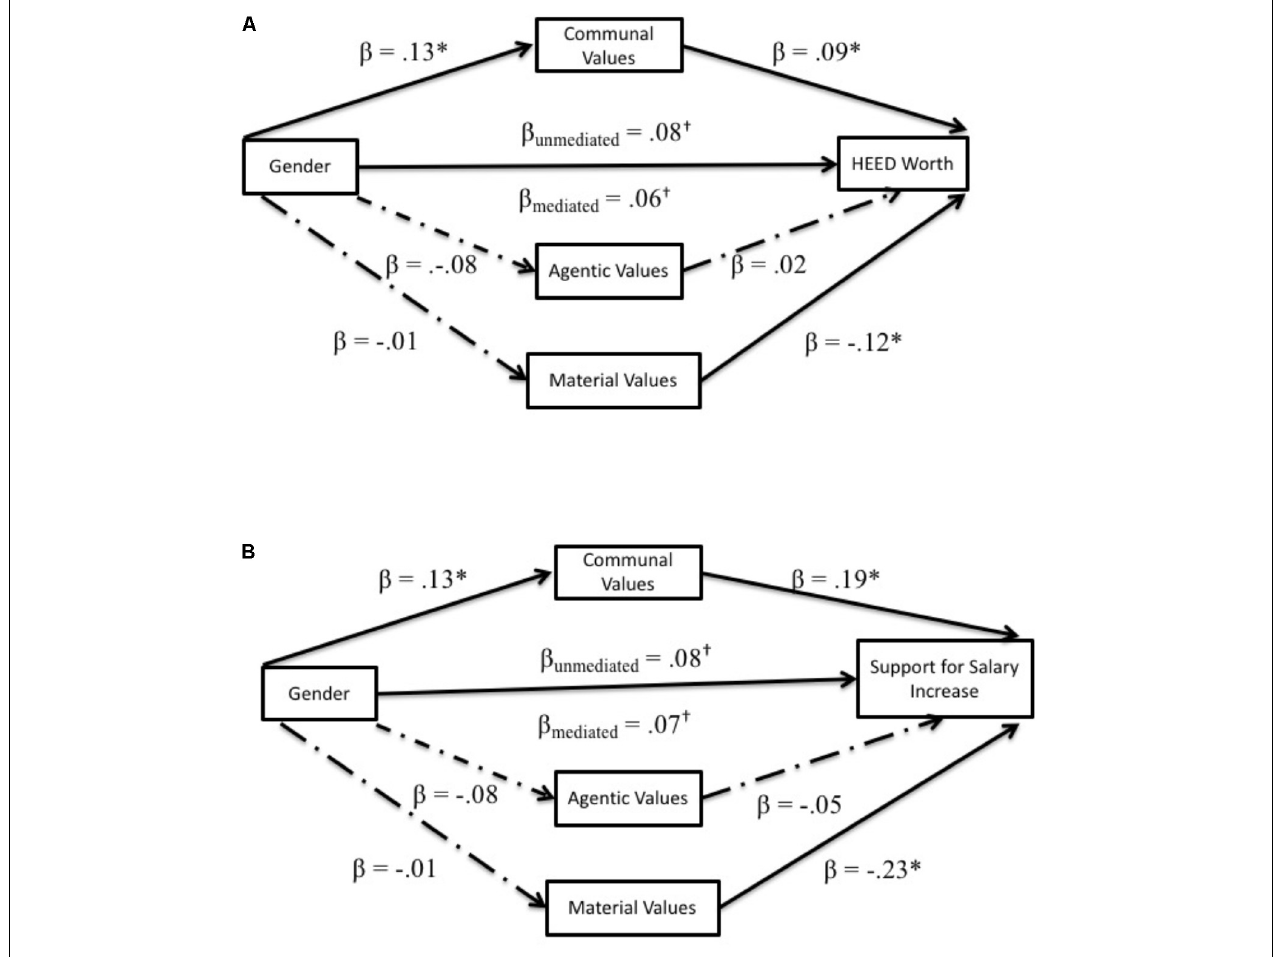
FIGURE 8 | Mediation models for HEED variables in Study 2. (A,B) Show mediation models for HEED related outcome variables. All mediators were entered simultaneously for each model. ∗ p < 0.05, † p <